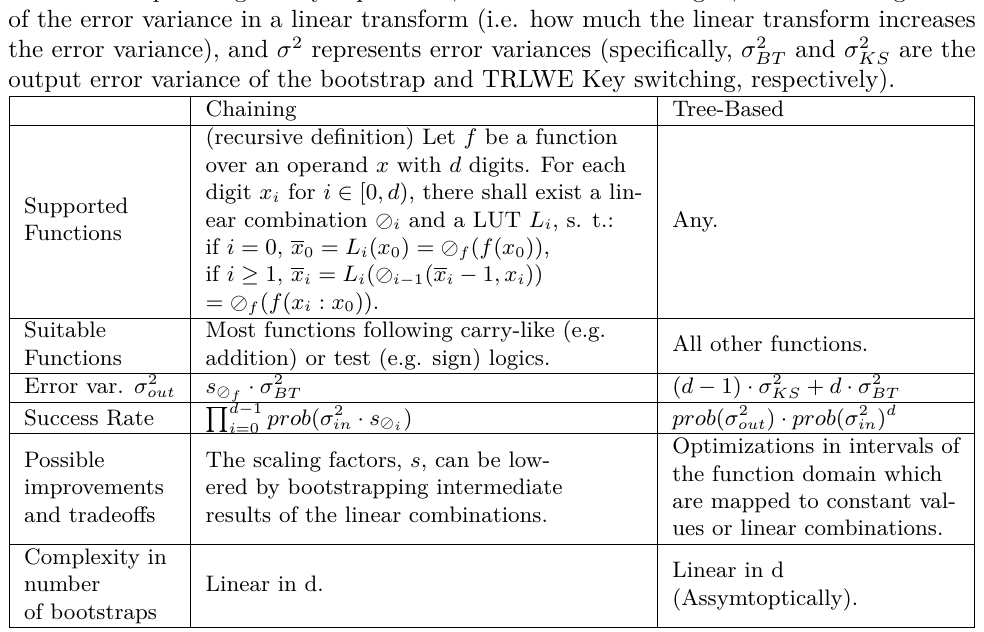
and σ 2 are the BT KS